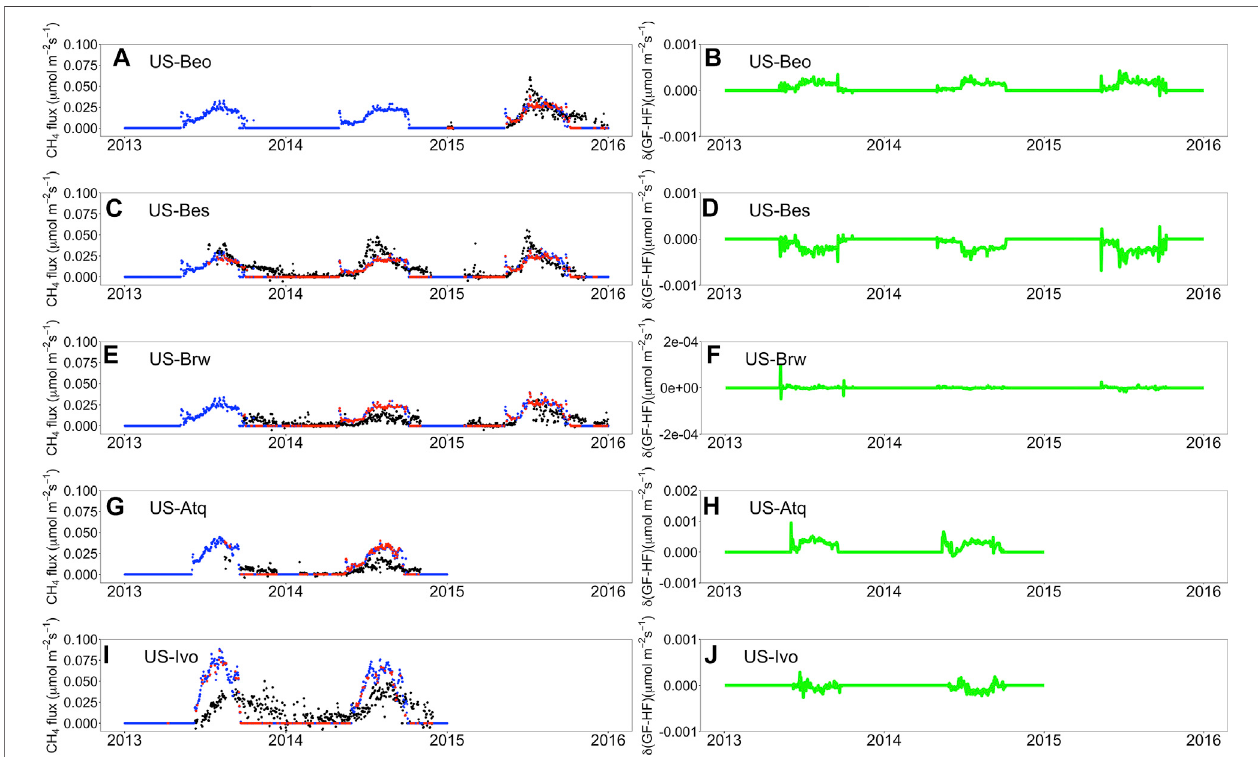
algorithm and 3.2 – 28 times of using the DF